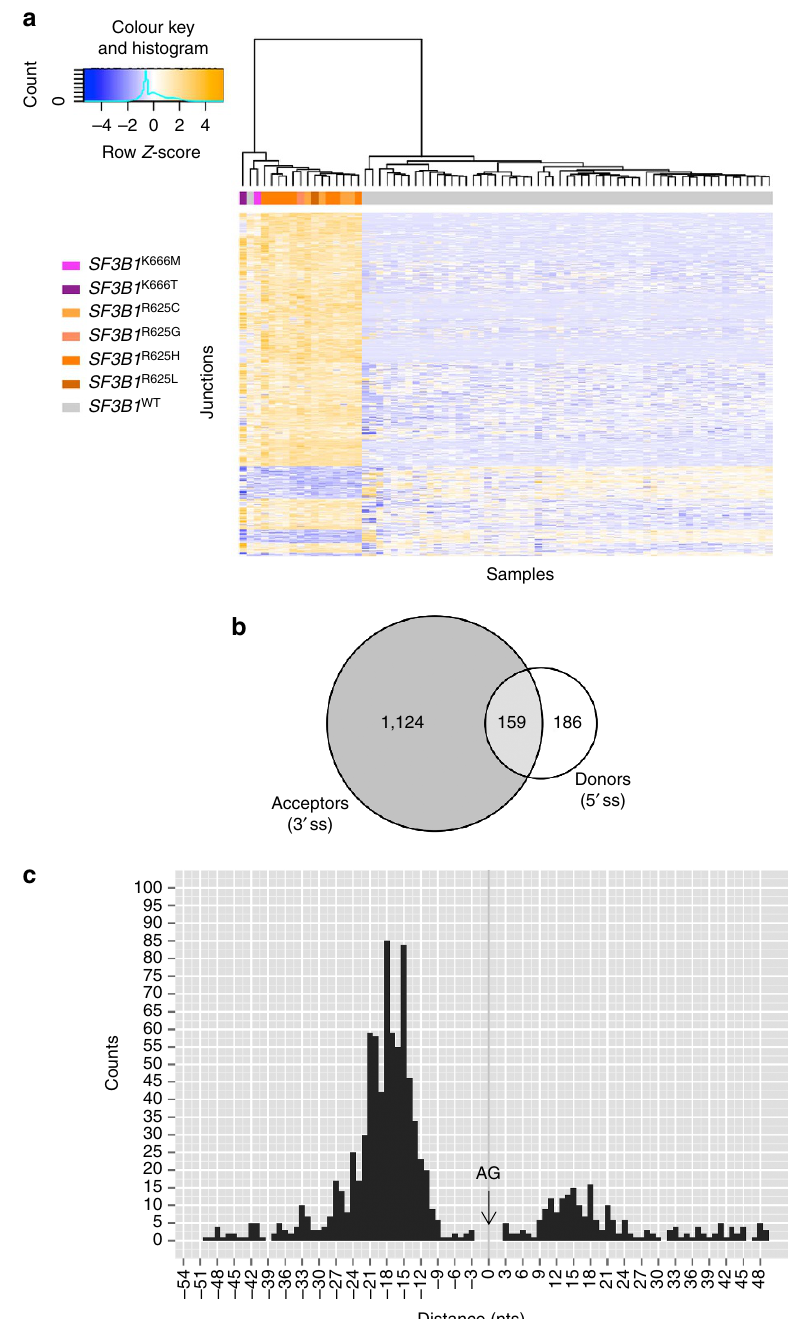
Figure 1 | Differential splice junctions in SF3B1 MUT tumours. ( a ) Hierarchical clustering and heat-map analysis of differential splice junctions in tumour samples. The colours of squares below the tree denote the subtype of each sample. Below the array tree and the subtype identification row, the heat map of the 1,469 splice junctions is shown. The complete list of up- and downregulated splice junctions can be found in Supplementary Data 1. ( b ) Venn diagram of differential splice junctions in SF3B1 MUT compared with SF3B1 WT tumours. Numbers show the count of alterations within only 5 0 ss (186 events) or only 3 0 ss (1,124 events). The overlapping area represents junctions that are either ambiguously attributed to an alternative donor or acceptor site, or attributed to both alternative 3 0 and 5 0 splice sites (159 events). ( c ) Distances between the alternative and canonical SF3B1 MUT -sensitive 3 0 ss. For alternative 3 0 ss within the 50nts preceding the canonical 3 0 ss (765), the distance between the alternative (AG’) and corresponding canonical (AG) 3 0 ss was plotted as a histogram. Negative distances mean the alternative AG’ upstream of the canonical AG, whereas positive distances mean the AG’ downstream. The 0 point demarks the position of the canonical cryptic 3 0 ss (53%) to be differentially expressed in our data set, demonstrating the robustness of this splicing pattern despite the differences in the series of analysed tumours and bioinformatics pipelines.